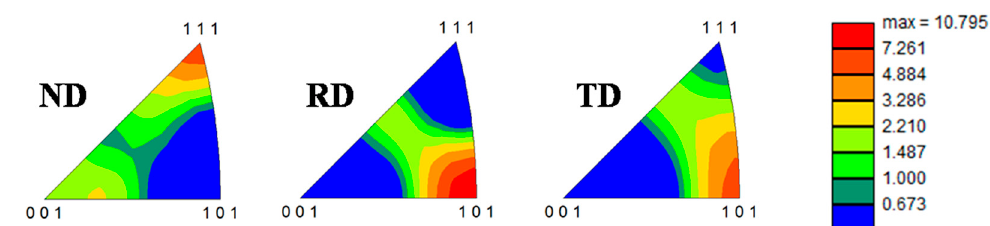
Figure 10. Inverse pole figures (IPFs) of Sample C, representing the preferred crystalline orientations in the axial direction (ND), radial direction (RD) and circumferential direction (TD) of the